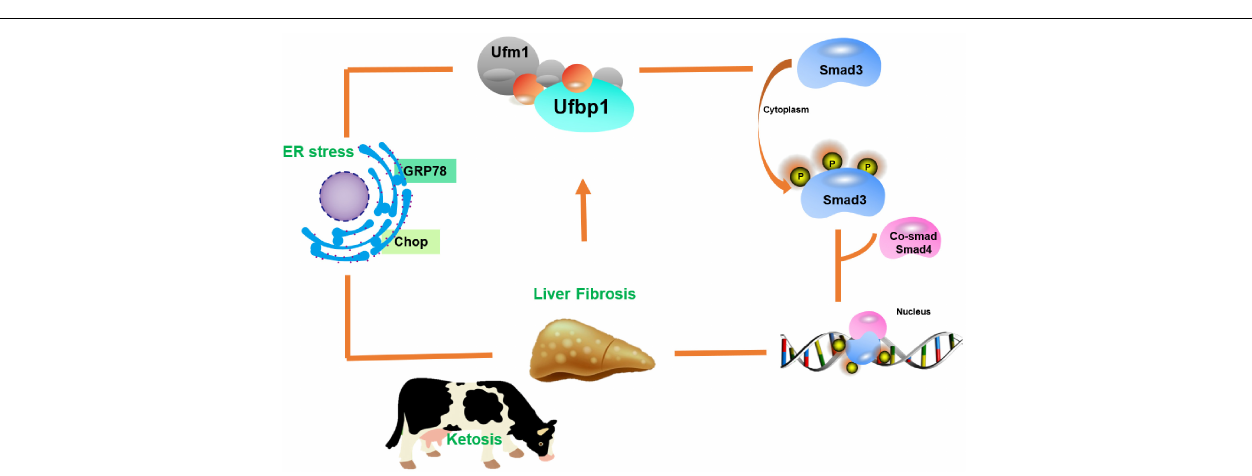
FIGURE 7 | Model illustrating role of Ufbp1-dependent-Ufmylation in the liver injury induced by ketosis. Ufbp1 protects animals from liver fibrosis via suppressing Smad3 activation and ER stress. In turn, liver injury induces Ufbp1-dependent-Ufmylation downregulation or even